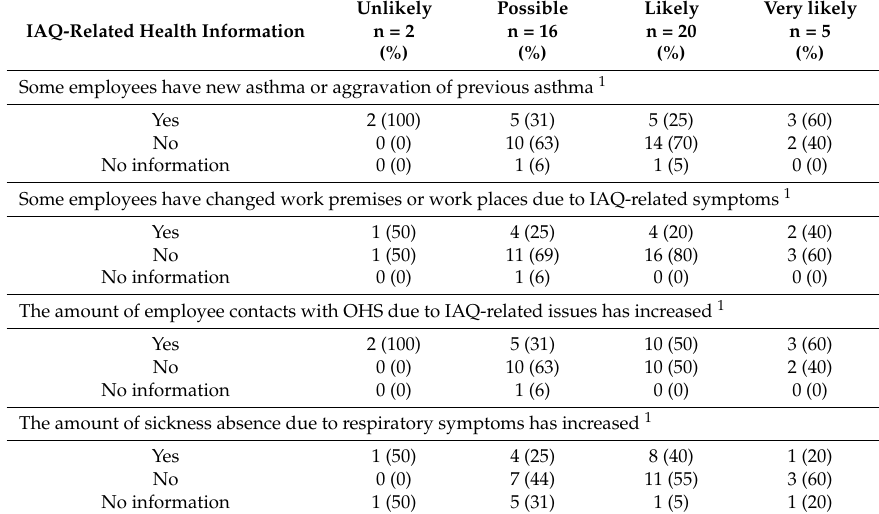
Table 5. IAQ-related group-level health information on employees (obtained from OHS), according to building floors or sections in which probability of abnormal IA exposure categories ( unlikely , possible , likely , very likely ) were